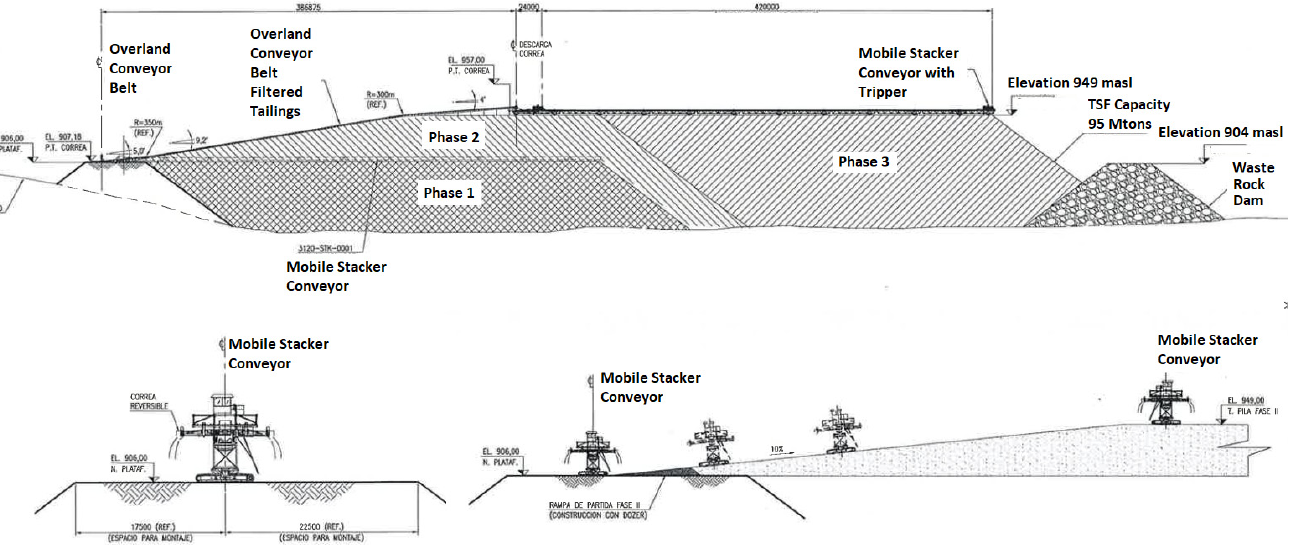
Figure 25. El Espino Filtered Tailings Storage–Layout and Typical Cross Section [51,52,60].